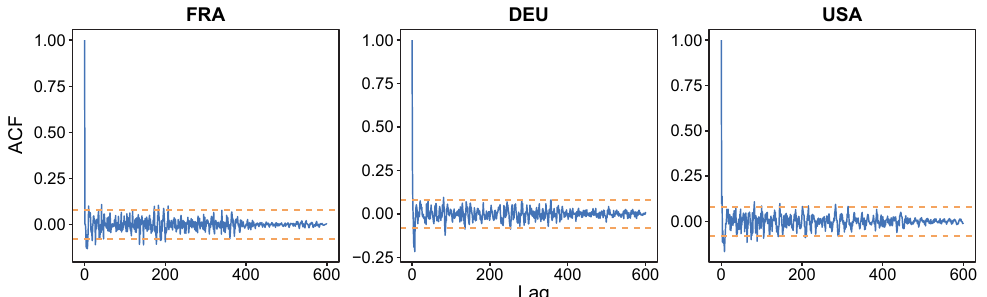
Figure 6. For France, Germany and USA, autocorrelation of the normalized error ε t , using the festive day correction, obtained with the R-software functionalities (acf() function). The orange dotted line provides the 95% confidence interval for non-correlation. Similar plots for the same countries and 33 more countries, without using the festive day correction, are displayed in Figure